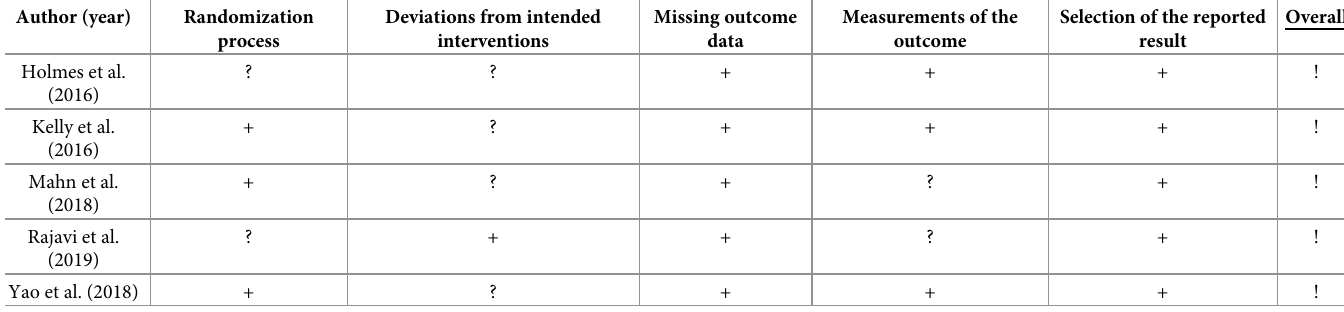
Table 2. Quality of the studies included in the meta-analysis assessed by revised Cochrane risk-of-bias tool for randomized trials (RoB 2).